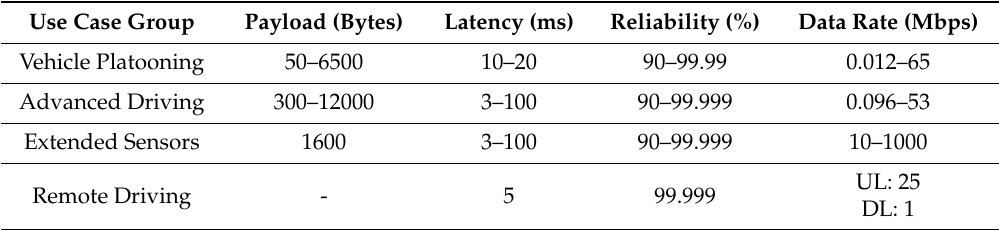
Table 3. Summary of V2X Performance Requirements in 3GPP TS